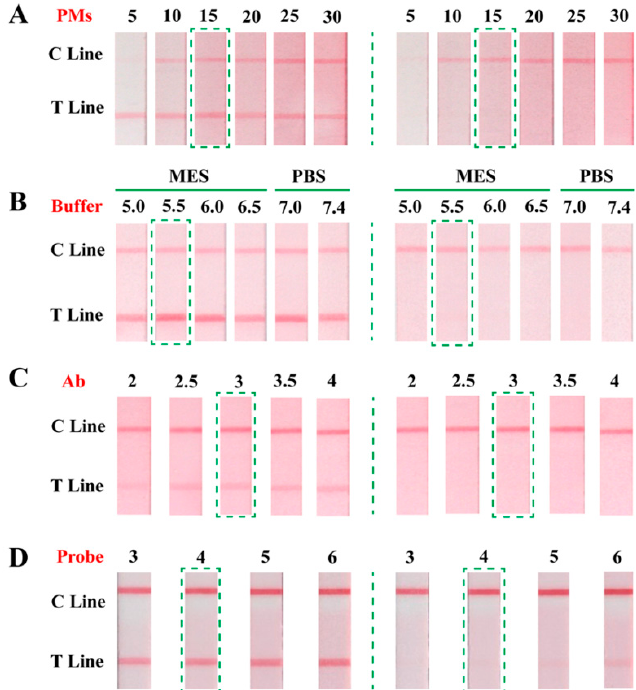
Figure 2. Optimization results of key parameters of PMs-ICA. ( A ) The amounts of PMs (5, 10, 15, 20, 25, 30). ( B ) The condition for activating carboxyl groups (0.05 mol/L MES pH 5, 5.5 6, 6.5; 0.01 mol/L PBS pH 7.0, 7.4. ( C ) The amount of mAb (2, 2.5, 3, 3.5, 4 µL). ( D ) The volume of immune probe (3, 4, 5, 6).